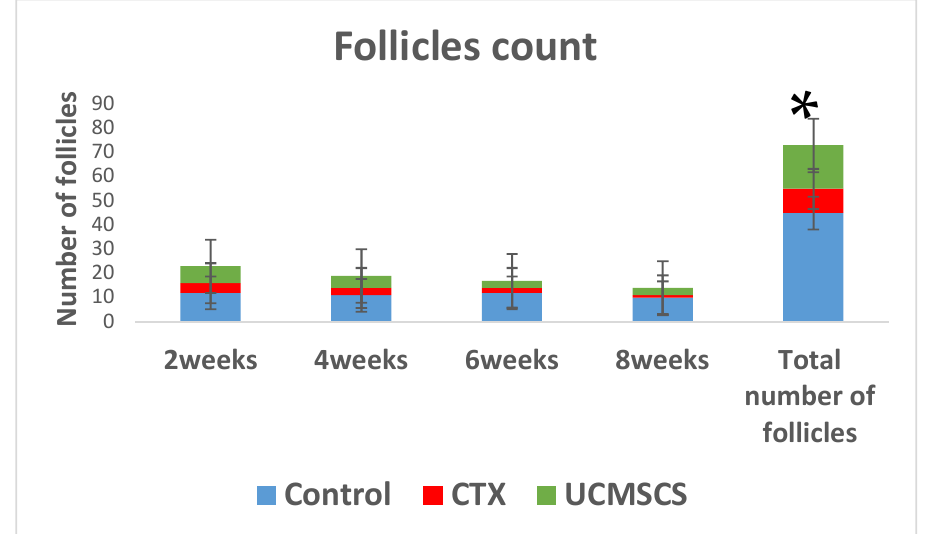
Figure 3. The follicles numbers are illustrated as percentage bars for the experiment groups, which showed the natural decline in control group in blue and the significant decline in CTX group in red, however, in total, the follicle count in umbilical cord blood mesenchymal stem cells (UCMSCs) group in green was significantly increased in the CTX group (* P < 0.05).